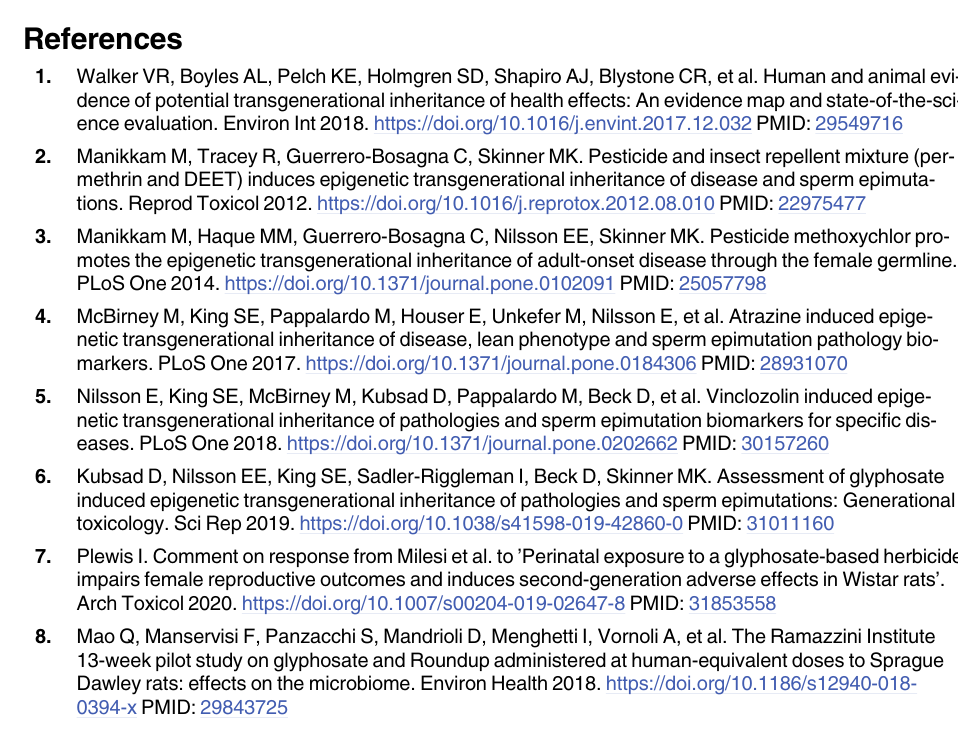
S1 Table. Number of F0 females by study, group and